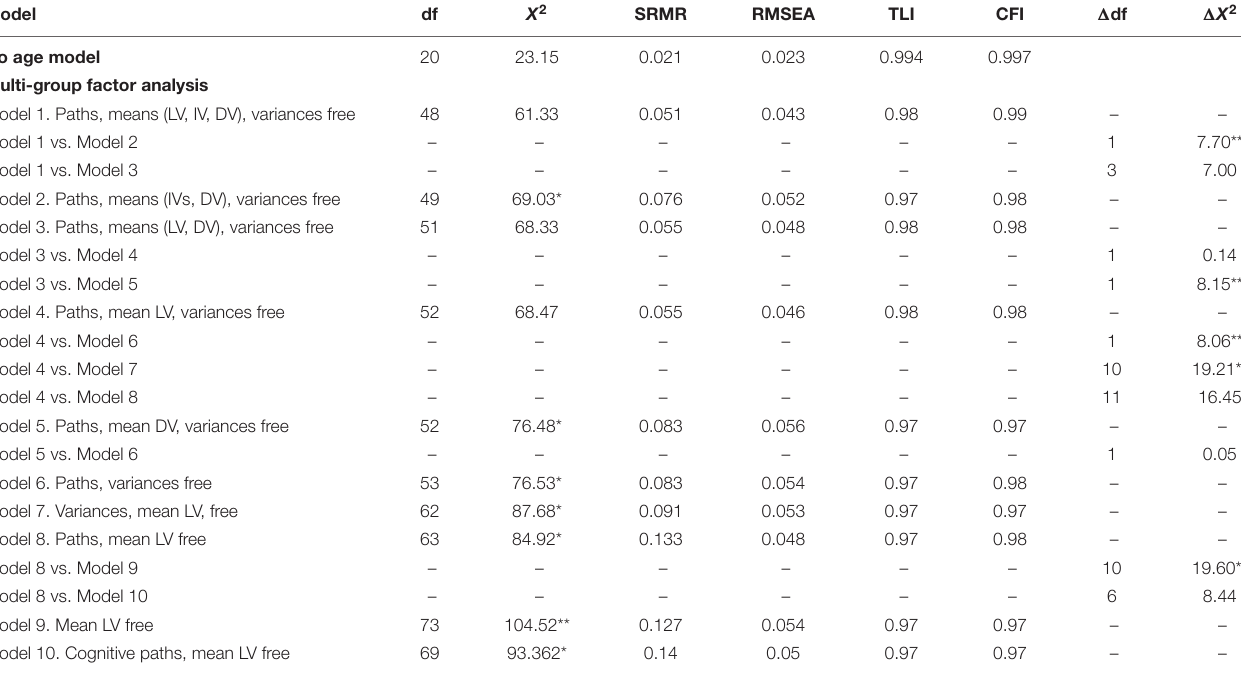
The first model is without age. The rest of the models are multiple group analyses testing measurement equivalence on different sets of parameters. The best fitting multiple group model as determined by (cid:49) X 2 is in italic. SRMR, Standardized Root Mean Square Residual; RMSEA, Root Mean Square Error of Approximation; TLI, Tucker-Lewis Index; CFI, Comparative Fit Index; (cid:49) df, change in df; (cid:49) X 2 , change in X 2 ; LV, latent variable; IV, Independent Variable; DV, Dependent Variable in this case latent cognition. *p < 0.05, **p <